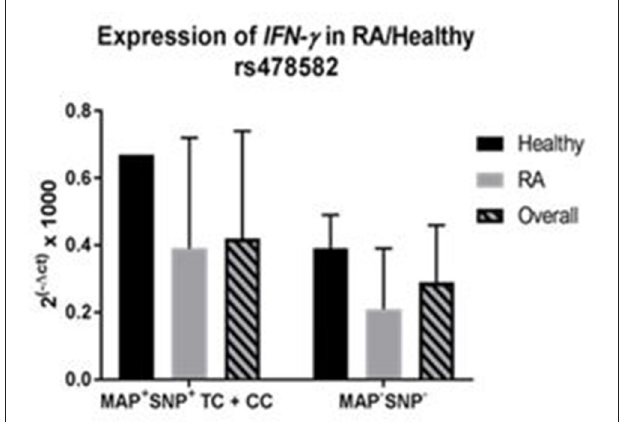
FIGURE 7 | Combined Effect of MAP and PTPN2:rs478582 on IFN- γ Expression in RA.